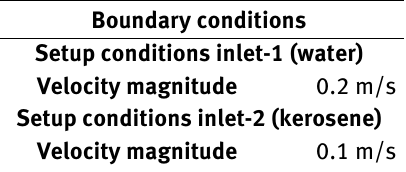
Table 5: Boundary conditions